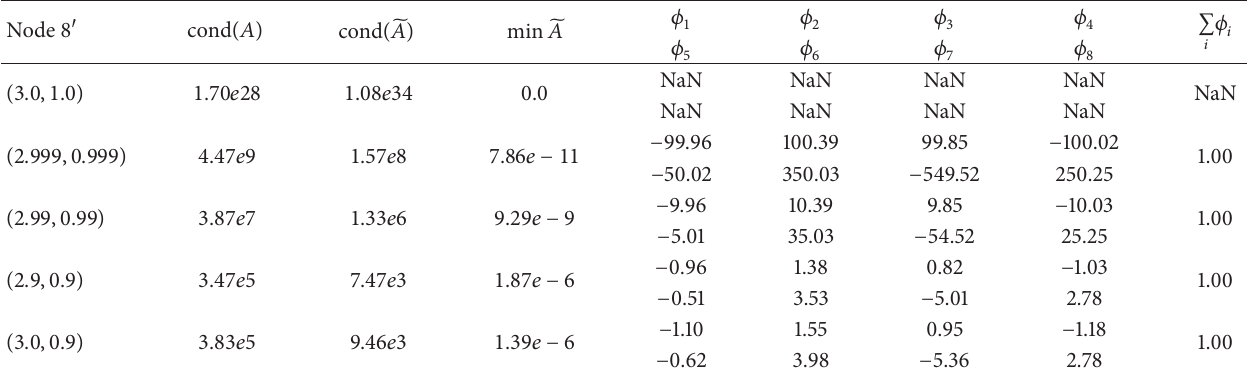
Table 1: Degradation cases and perturbation of shape